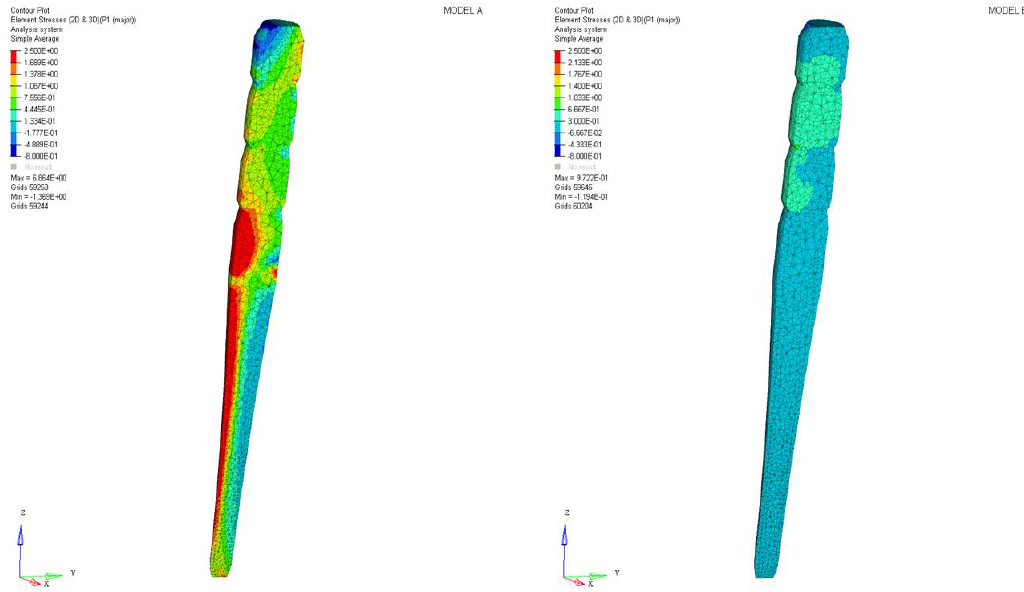
Figure 4. Maximum principal stress distribution (MPa): post A and post B.